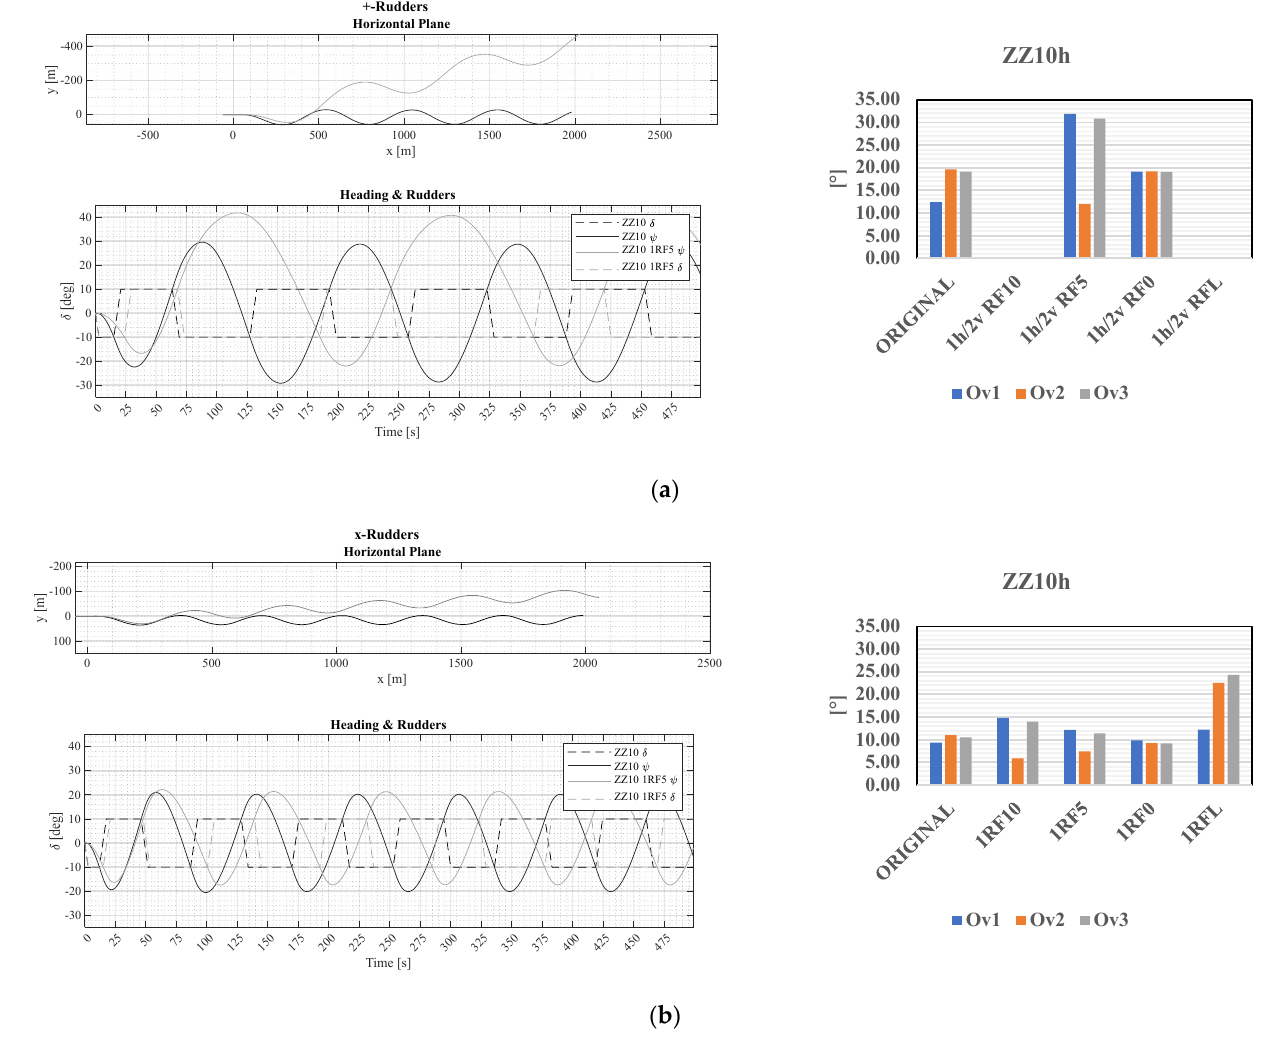
Figure 18. ( a ): SMG +-Eq—Horizontal zigzag in #1 plane jammed or lost condition. ( b ): SMG x-Eq— Figure 18. ( a ) SMG +-Eq—Horizontal zigzag in #1 plane jammed or lost condition. ( b ) SMG x-Eq— Horizontal zigzag in #1 plane jammed or lost condition. Horizontal zigzag in #1 plane jammed or lost